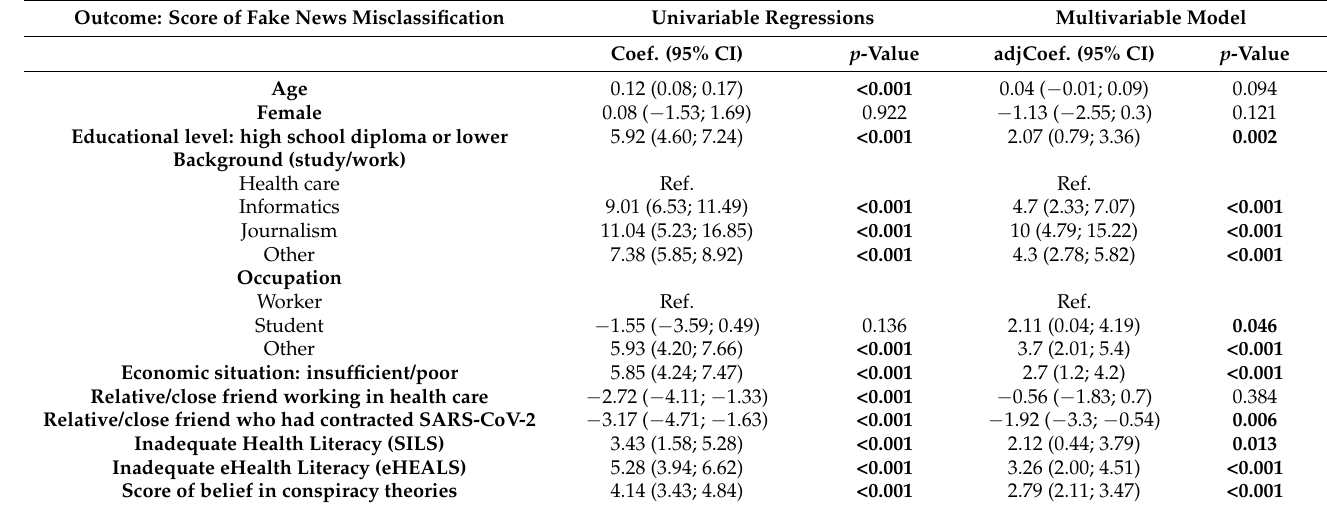
Table 4. Univariable and multivariable logistic regressions with the score of fake news misclassifica- tion as